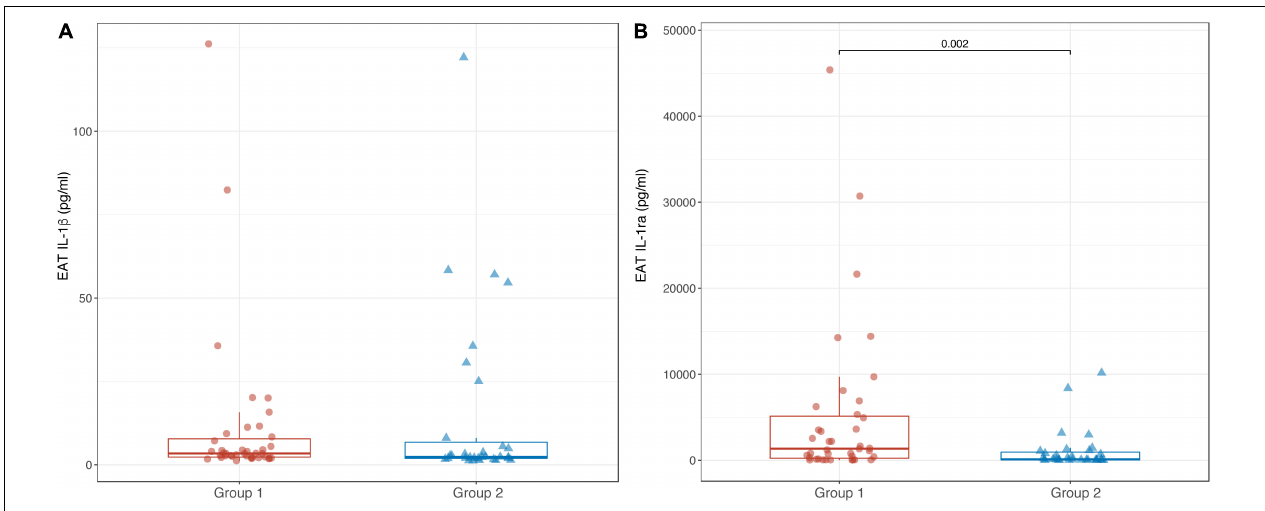
FIGURE 4 | Box-plots showing EAT levels of IL-1 β (A) and IL-1ra (B) in Groups 1 and 2. Boxes are defined by Q1, median (bold line) and Q3. Whiskers reach the minimum and the maximum of the distribution except for the presence of outliers, defined as data points below Q1 – 1.5 × IQR or above Q3 + 1.5 × IQR. To avoid overlapping a small amount of horizontal jitter was added. Q1, first quartile; Q3, third quartile; IQR = Q3 –